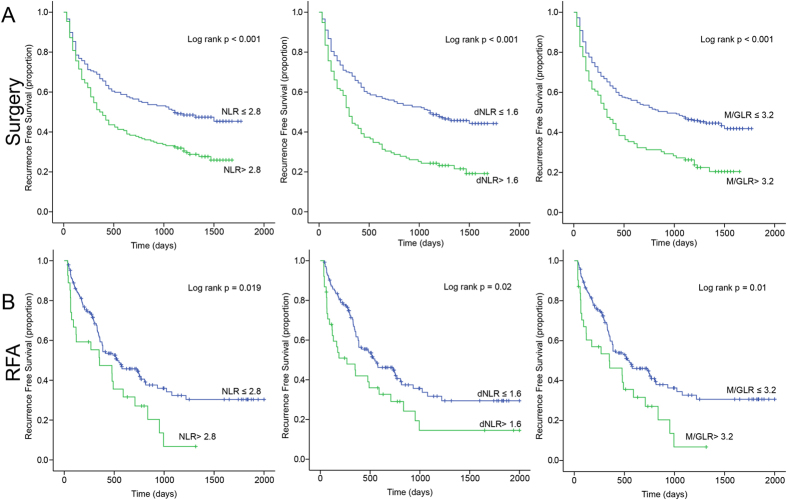
Kaplan-Meier survival curves for recurrence free survival in surgery (A) and RFA (B).